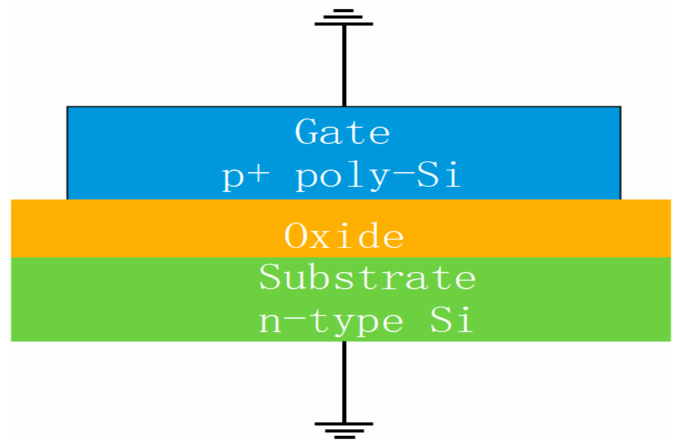
The oxide field is